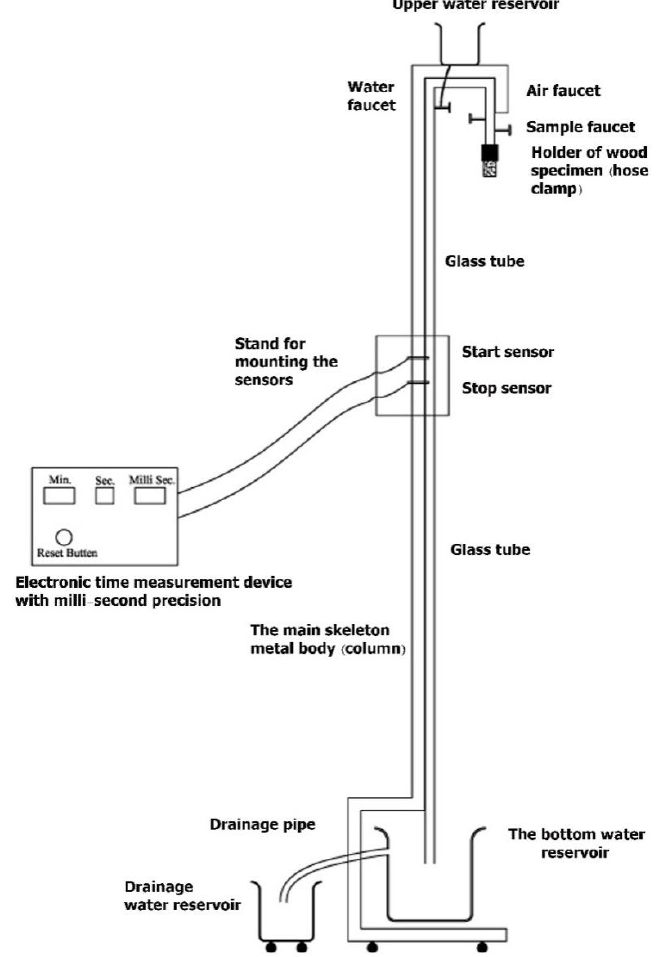
Figure 2. Schematic of the specific gas permeability measurement apparatus, equipped with a single-phase electronic time measurement device with millisecond precision (confirmed by the official certificate No. 47022; issued by The Iranian Research Organization for Scientific and Technology) (USPTO 8079249 B2) [60,61].